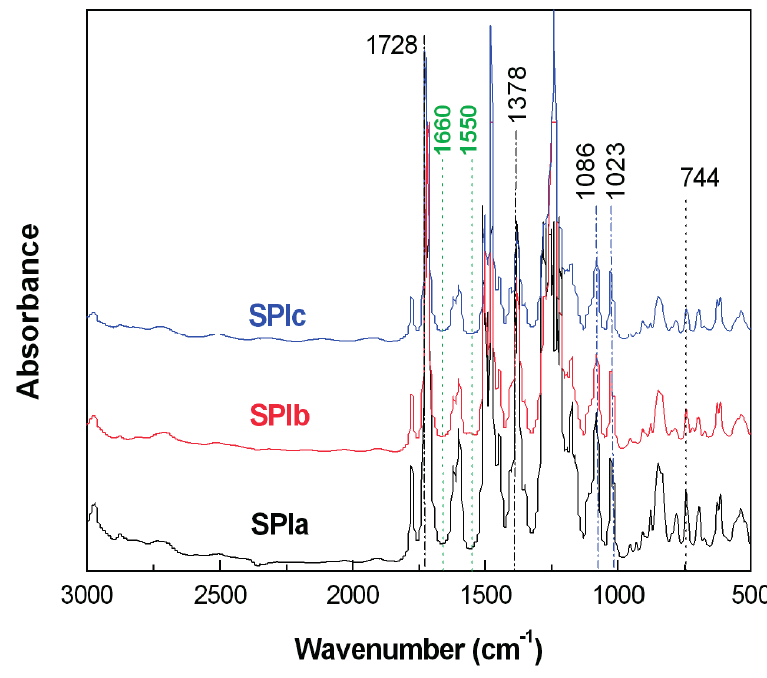
Figure 2. FTIR spectra of